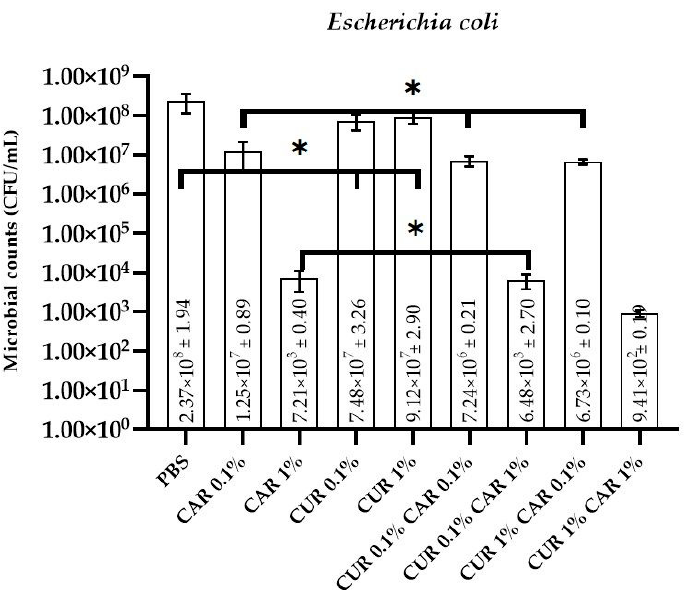
Figure 1. The effect of PBS-based neat and modified films on the viability of Escherichia coli cells; one-way ANOVA: *— p > 0.05.